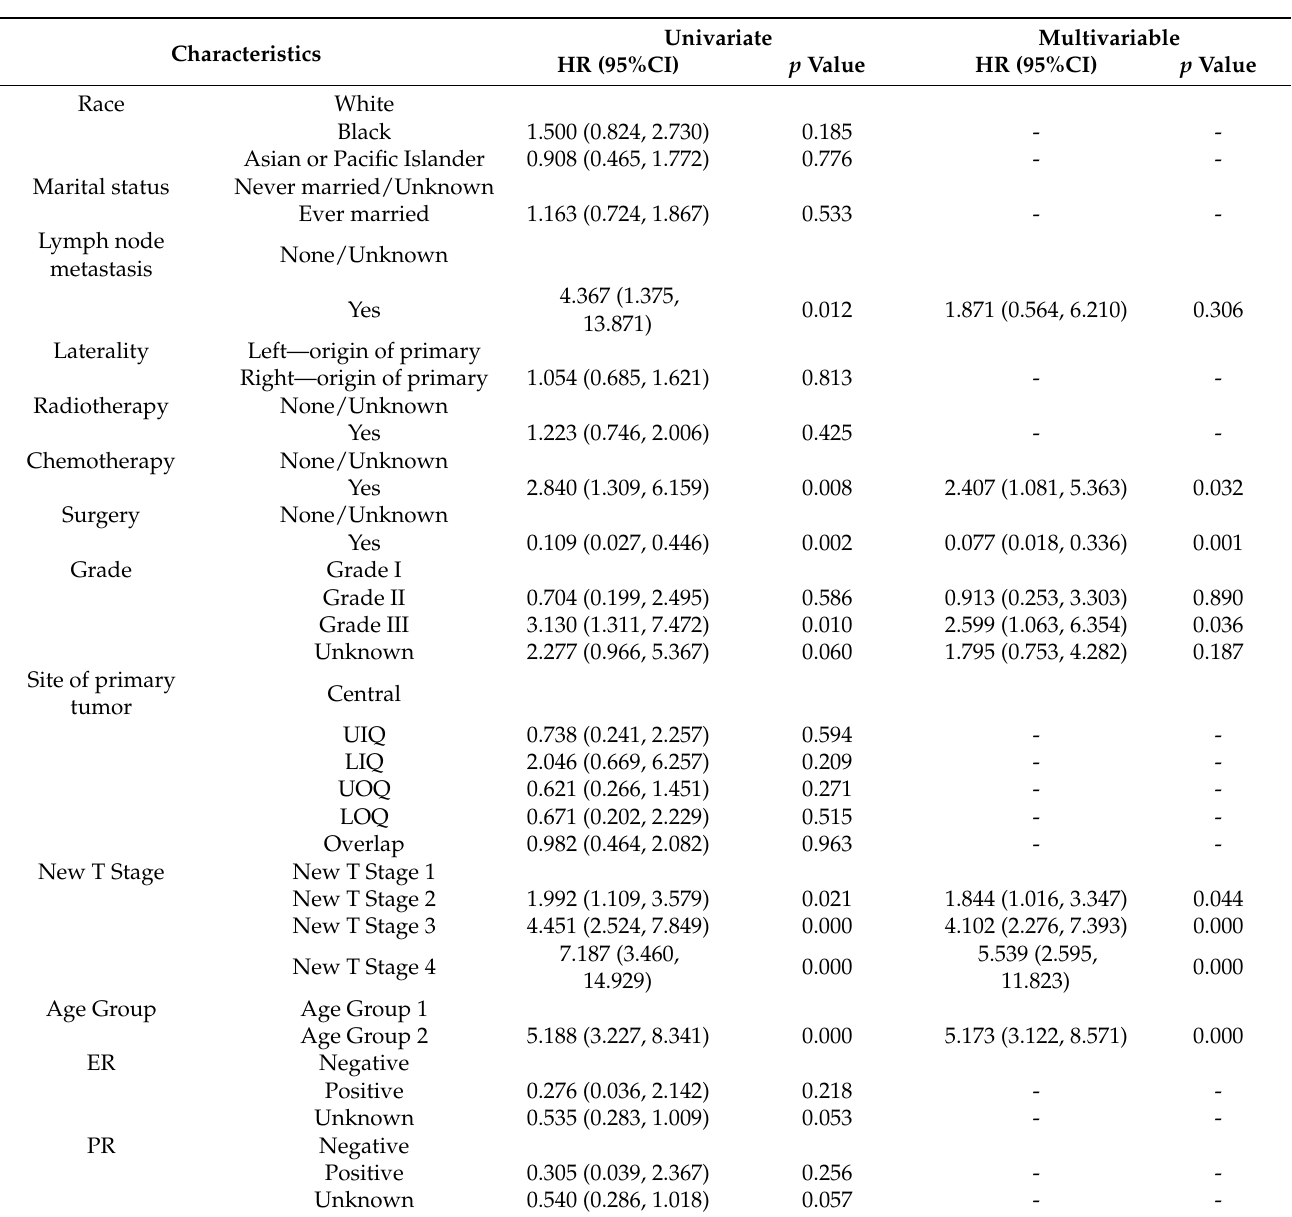
Table 4. Univariate and multivariate Cox proportional hazards regression of malignant phyllodes